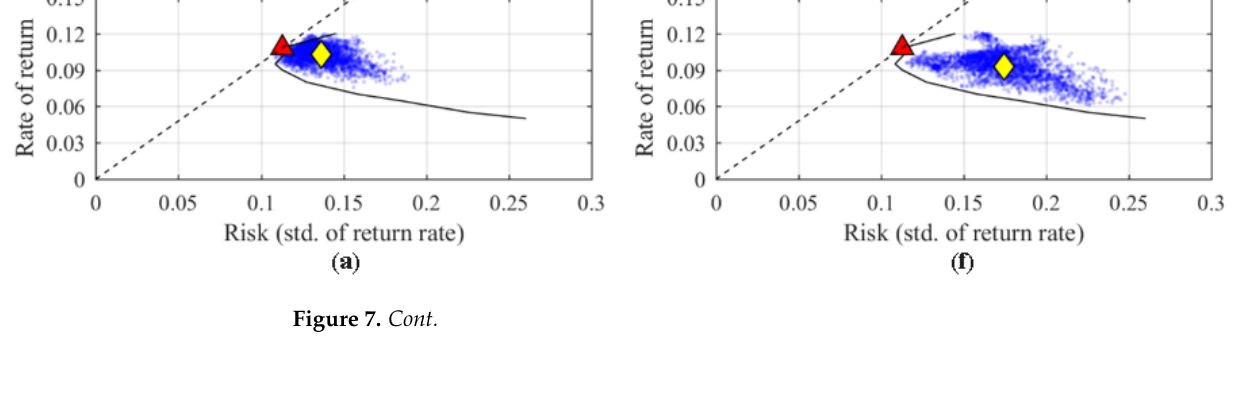
Figure 7. Risk-return graphs according to the Euclidean distance groups. ( a ) Group 1; ( b ) Group 2; ( c ) Group 3; ( d ) Group 4; ( e ) Group 5; ( f ) Group 6; ( g ) Group 7; ( h ) Group 8; ( i ) Group 9; ( j ) Group 10. Table 6. Summary statistics of the mean return and the risk according to the Euclidean distance groups. Group